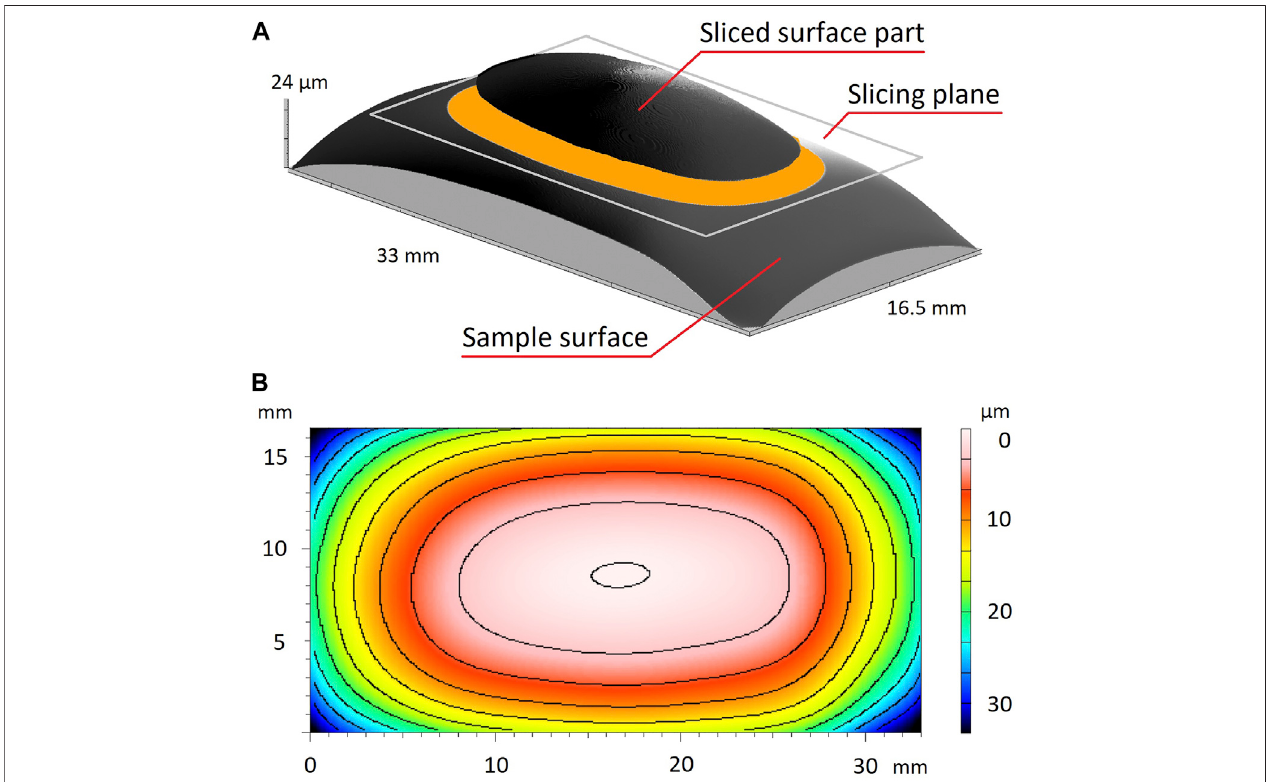
FIGURE 5 | (A) Representation of the sample slicing method. Virtual slicing plane separates the sliced surface from the full surface, and the contact area is then calculatedfortheslicedpart. (B) Contourmapexamplesofaslicedsamplesurface.Slicinginthepresentedimagewasperformedin3 µmstepsfromthehighestsurface peak. The obtained contours demonstrate which part ofthe surface would be in contact with ice at various depths. Due to the surface curvature, the real contact area is signi fi cantly smaller than the nominal surface area. If the full surface measurements would not be performed, the curvature of the sample surfaces could not be observed and could cause misinterpretation of